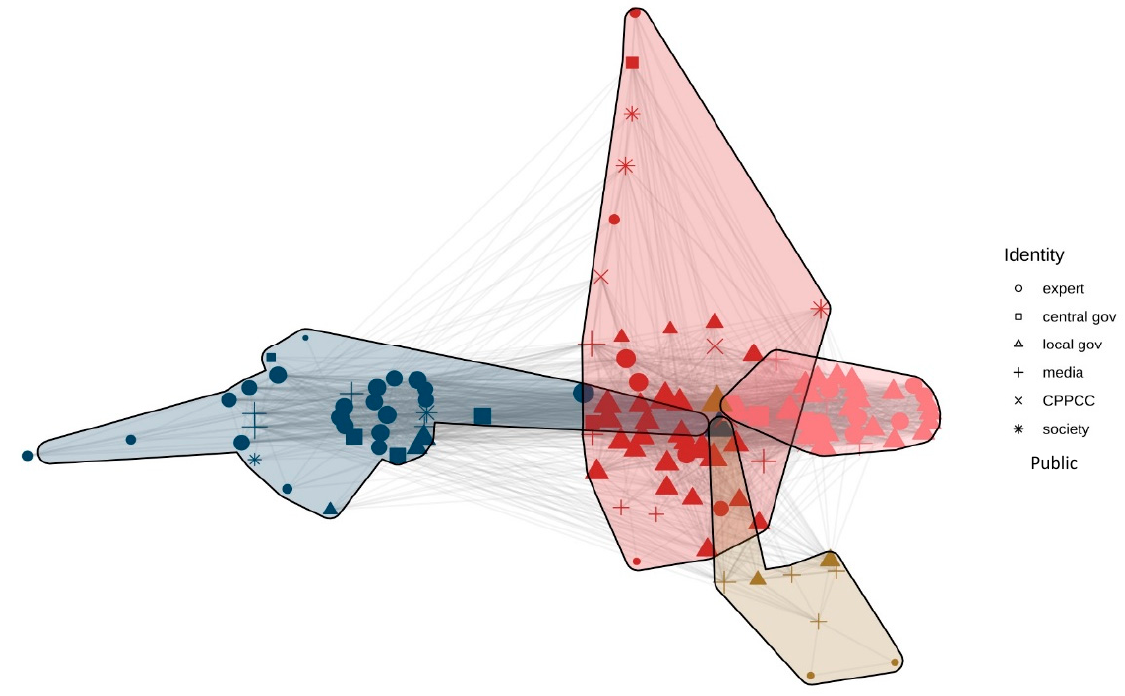
Figure 4. Discourse network visualisation (2004–2009). Note: Gov = government; CPPCC = Chinese People’s Political Consultative Conference; Red = dominant coalition; Blue = minority coalition; Yellow = the other coalition.